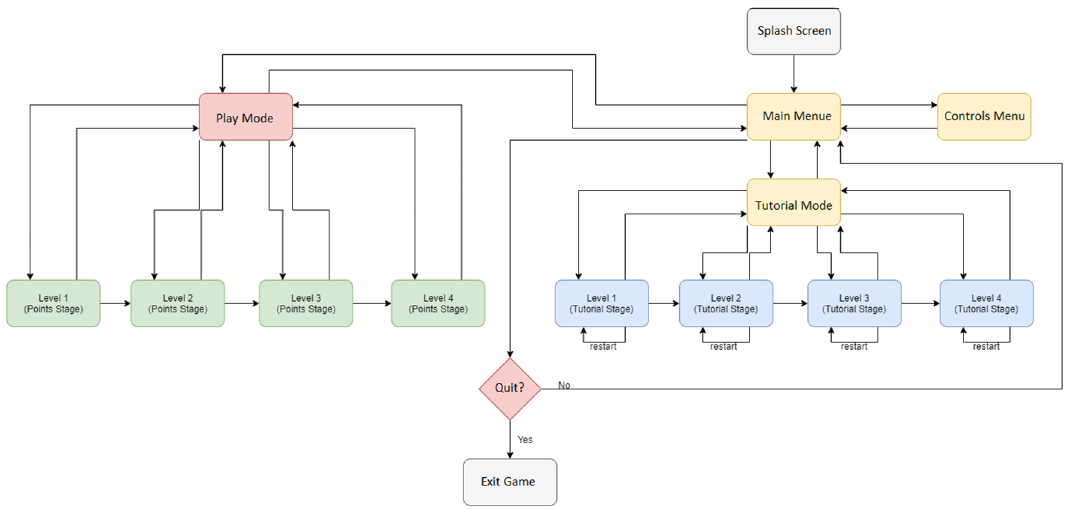
Figure 8. Game flow of the serious